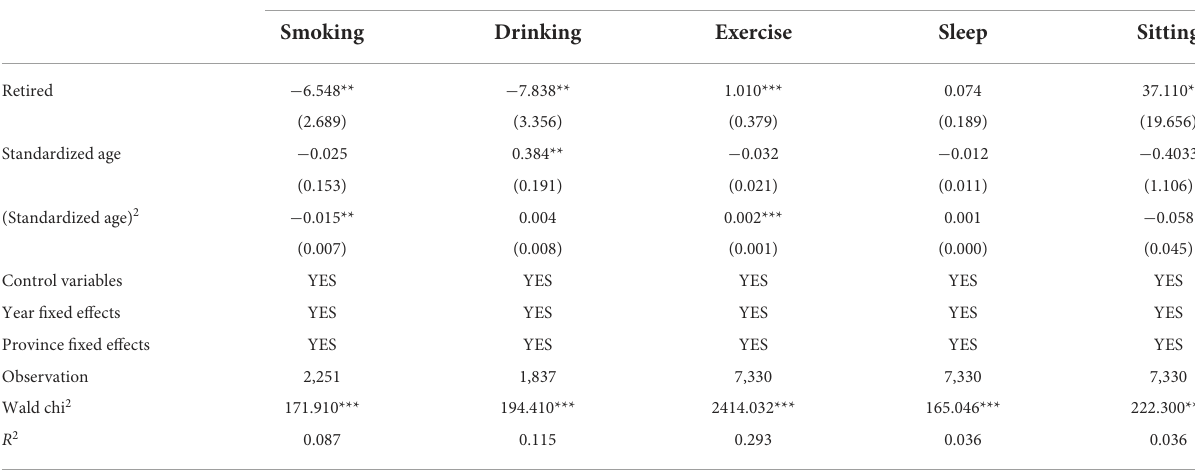
TABLE 3 Regression results from the second stage of the